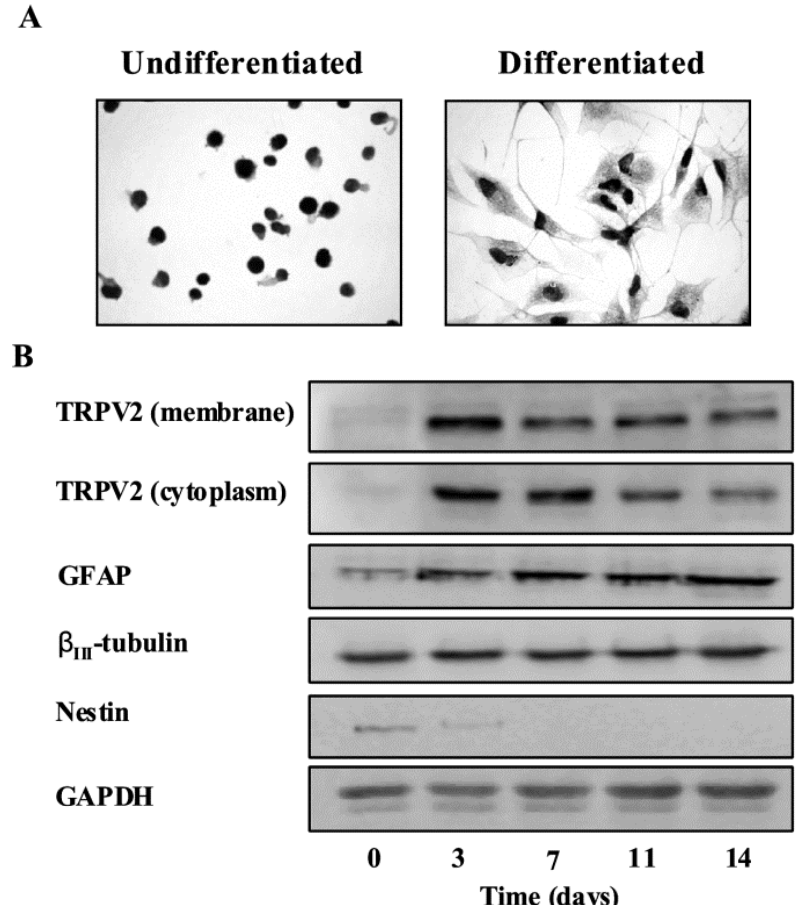
Figure 1. TRPV2 protein expression during GSC differentiation. ( A ) TRPV2